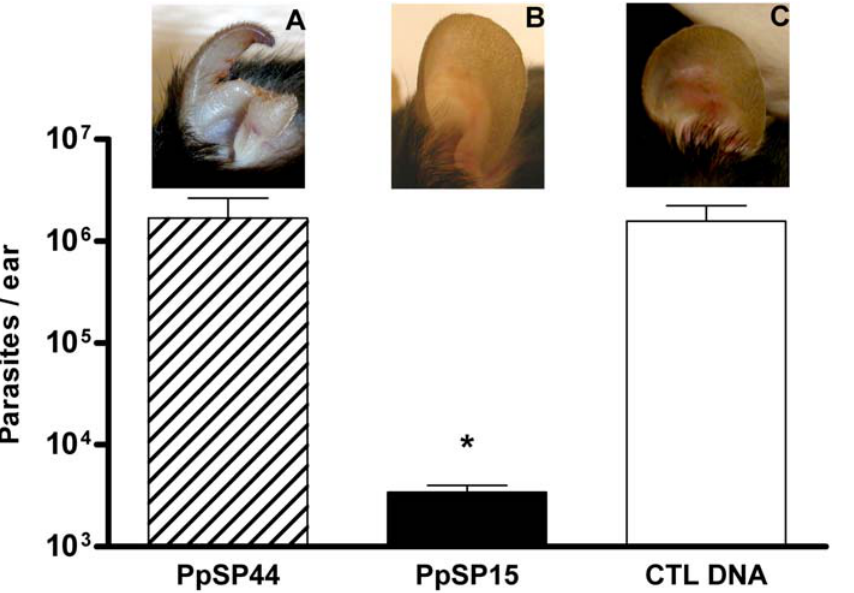
Figure 3. Protection or exacerbation of L.major infection in mice immunized with PpSP15 or PpSP44. Mice immunized with PpSP15, PpSP44 or CTL DNA were challenged with 500 L. major metacyclics and 0.5 pairs of SGH. The graph shows the number of parasites per ear at 11 weeks post-challenge as measured by Real time PCR. This result is representative of the parasite load at six and nine weeks post-challenge. Bars represent the mean 6 the SEM for ten mice per group. Panels A–C reflect the pathology of the ears 11 weeks post-challenge in mice previously immunized with PpSP44 (A), PpSP15 (B) and CTL DNA (C). Asterisks indicate significance compared to mice immunized with CTL DNA ( p , 0.05). Data are representative of three independent